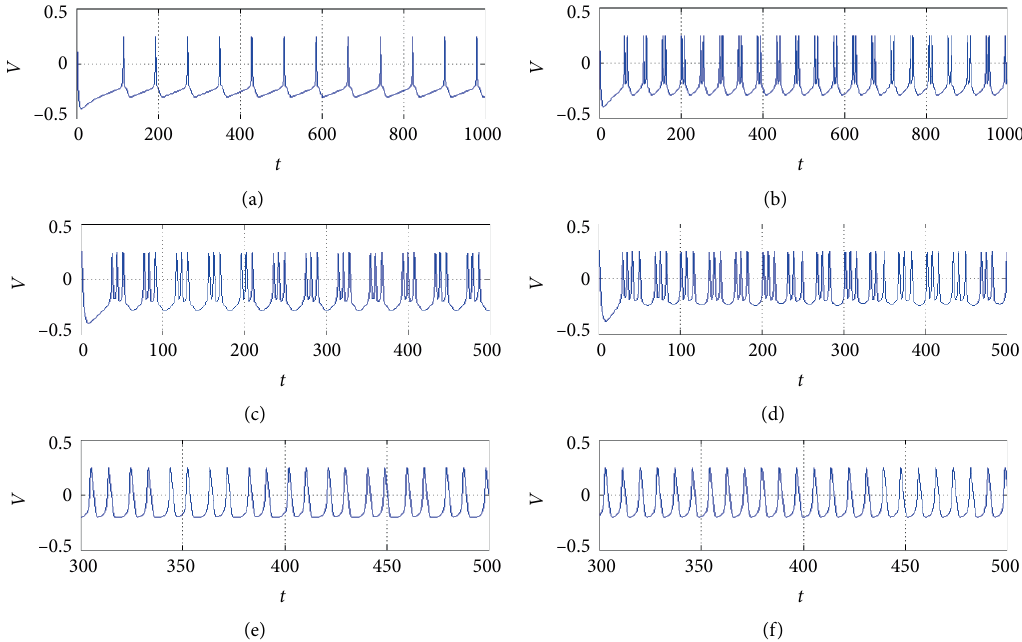
Figure 6: Sampled time series for membrane potential when 𝑘 , (b) period-2 bursting with 𝑘 with 𝑘 2 = 0.25 , and (f) spiking with 𝑘 bursting with 𝑘 2 = 0.6